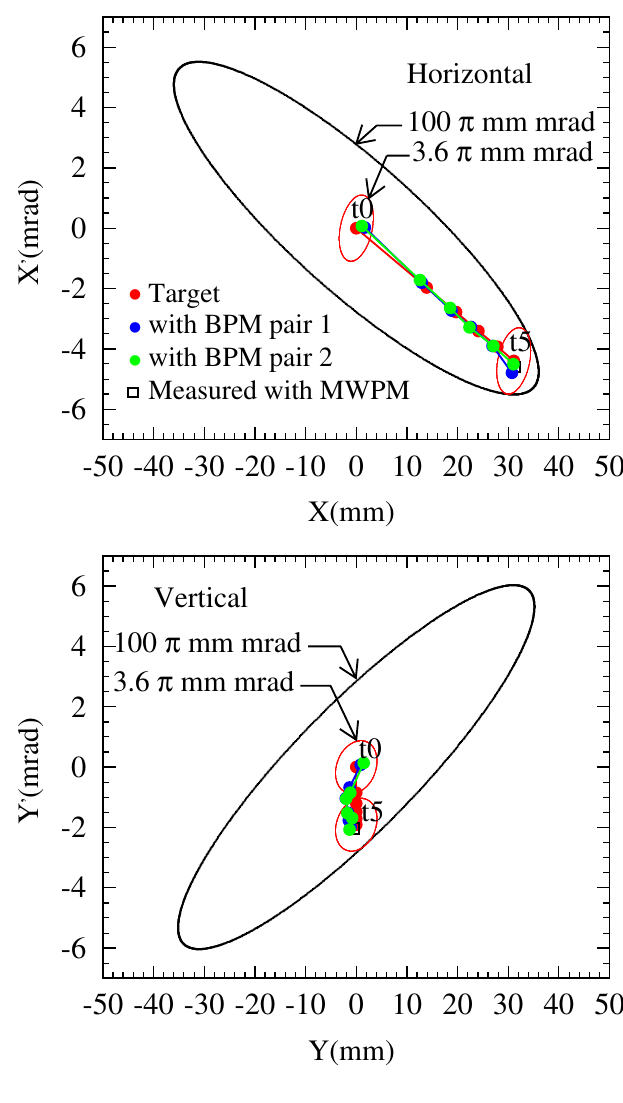
FIG. 8. (Color) Reconstructed phase space footprint obtained using Eq. (13) for a correlated (center to outside for both the horizontal and vertical direction) painting injection of 100 (cid:1) mm mrad . Here also the measurement was done with six different timings of the paint bump decay pattern of 500 (cid:2) s . The legend is the same for both figures. The results obtained here were also found very consistent and followed the expected linear red line in each direction. The results obtained here can be compared with those obtained for the same painting area of 100 (cid:1) mm mrad but done separately in the horizontal and vertical directions, given in Fig. 7, and found quite